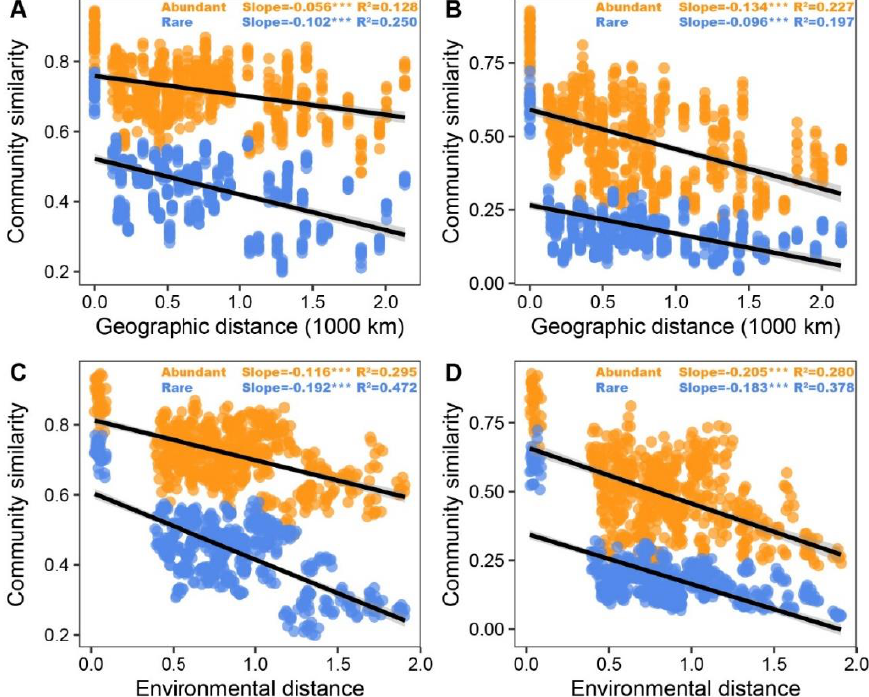
Figure 2. Distance–decay curve of changes in geographic distance ( A , B ) and environmental variables ( C , D ) versus rhizosphere bacterial ( A , C ) and fungal ( B , D ) β -diversity of the abundant and rare taxa.***, p < 0.001